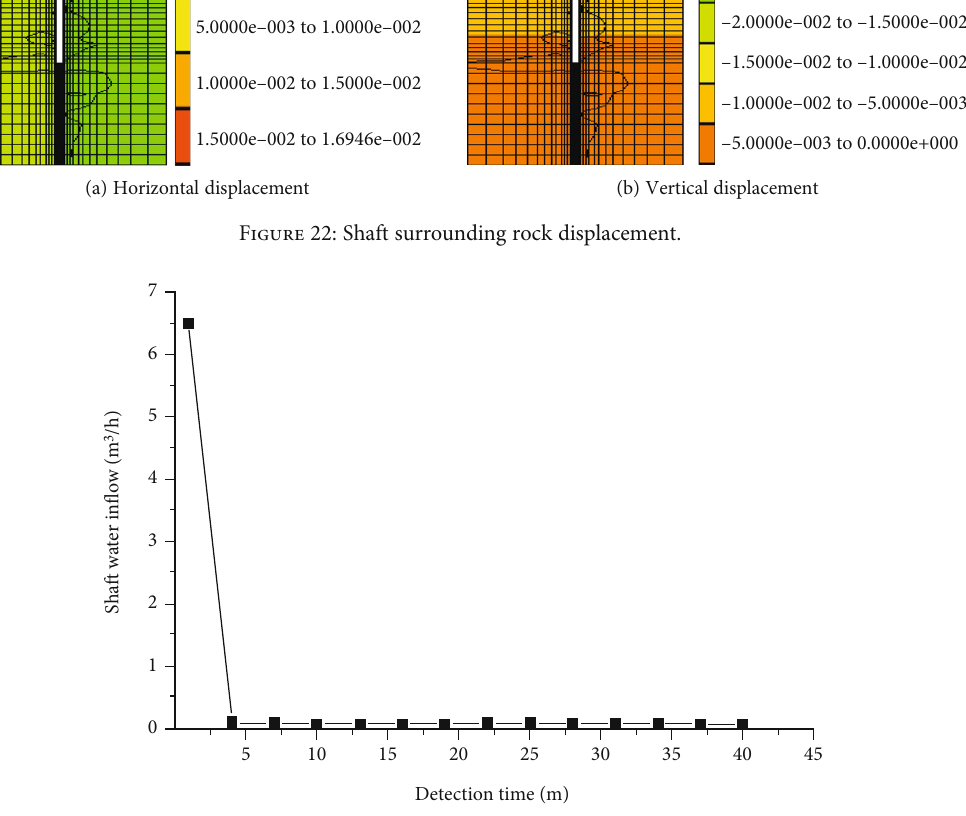
Figure 23: The measured water volume changes in the shaft.